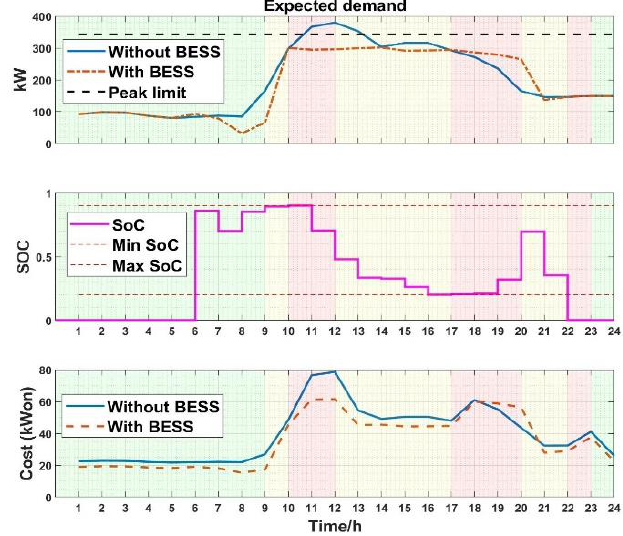
Figure 6. DMS results of PEV’s SoC schedule vs. original demand and cost before and after DMS.